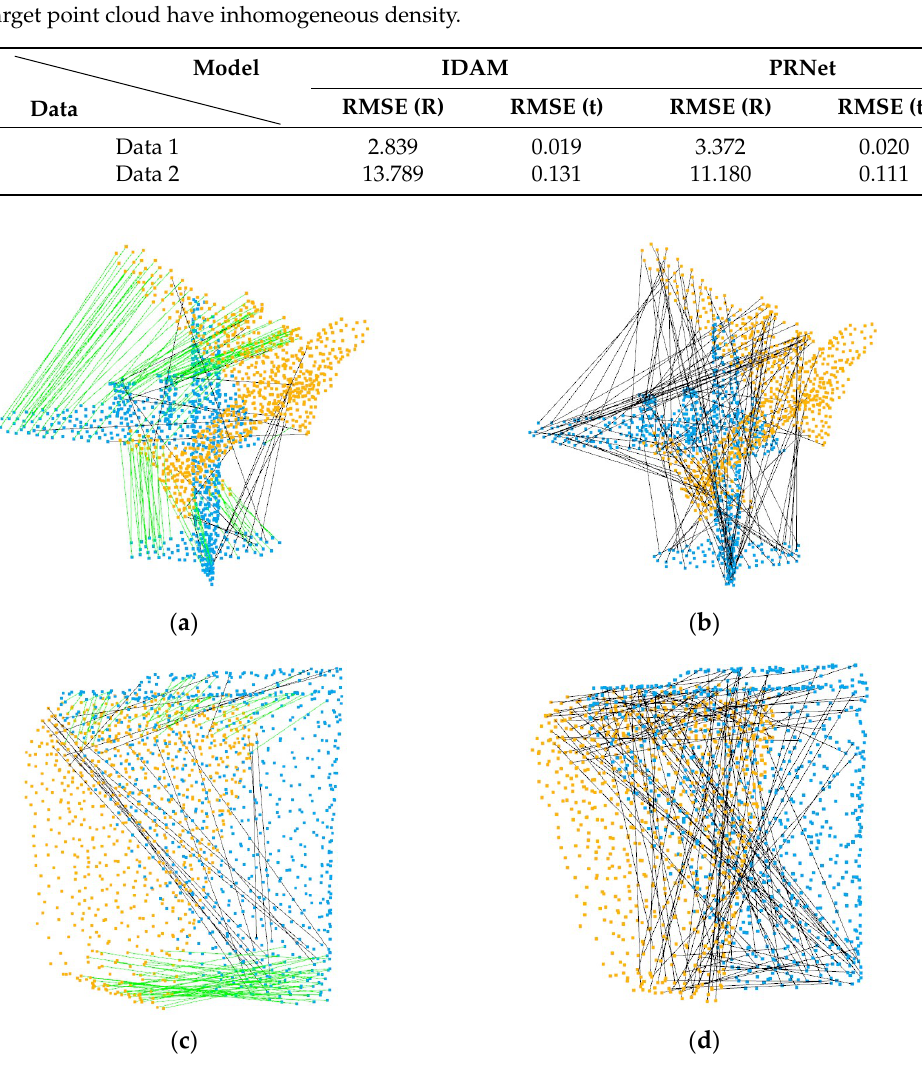
Figure 6. Correspondences predicted by IDAM. ( a , c ) Point clouds with the same distribution, ( b , d ) point clouds with inhomogeneous density. The green lines represent the correct correspondences, and the black lines represent the error correspondences. Table 2. Results of networks with different data. Data 1 represents that the source point cloud and the target point cloud use the same data, and Data 2 represents that the source point cloud and the target point cloud have inhomogeneous density.